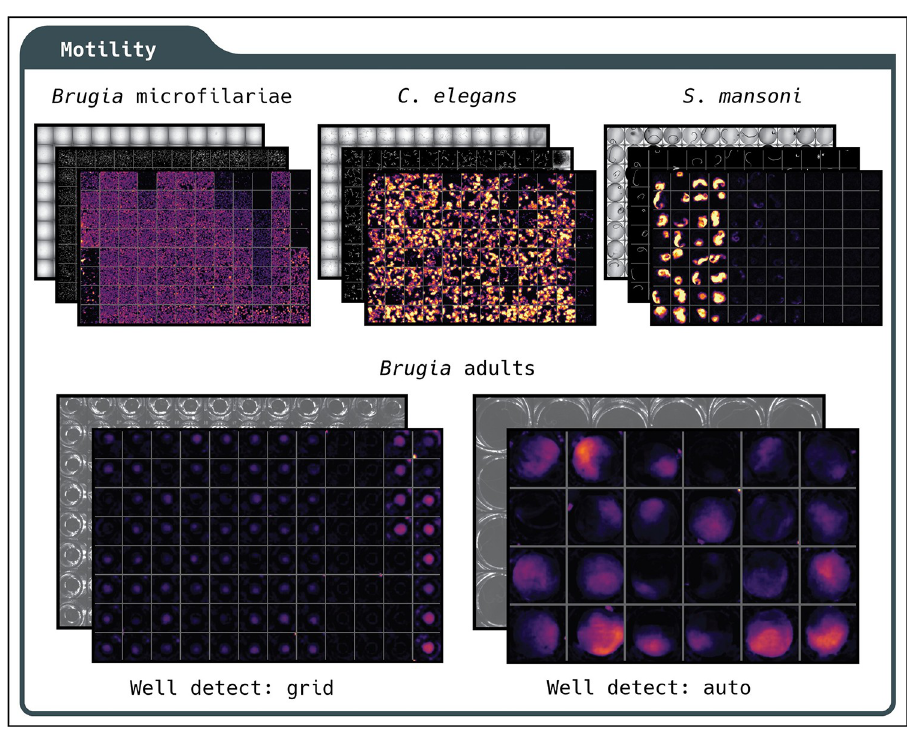
Fig 3. Using wrmXpress to measure motility of diverse worms imaged using a variety of parameters and approaches. Motility of B . malayi microfilariae, C . elegans adults, S . mansoni adults, and Brugia spp. adults. Top images represent data acquired with a high-content imager, and bottom images represent data acquired with a simple camera imaging an entire plate on a glass stage. For whole-plate imaging, wells can be split automatically using well identification or using a pre-established grid based on user-input values. Diagnostic images include a single frame of transmitted light, binary segmented worms, and a flow cloud.